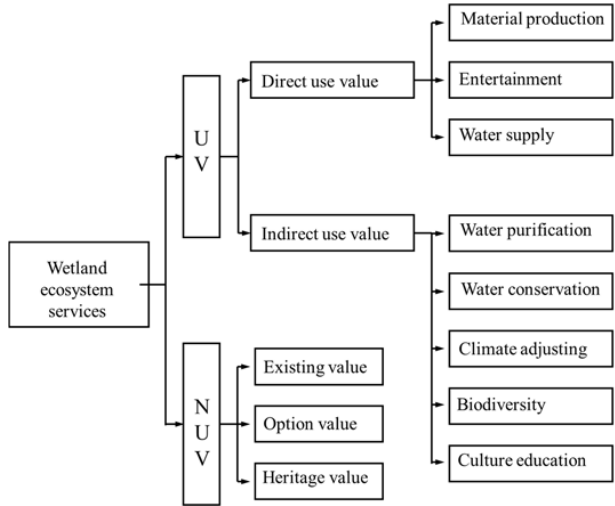
Figure 1. The classification of wetland ecosystem services.